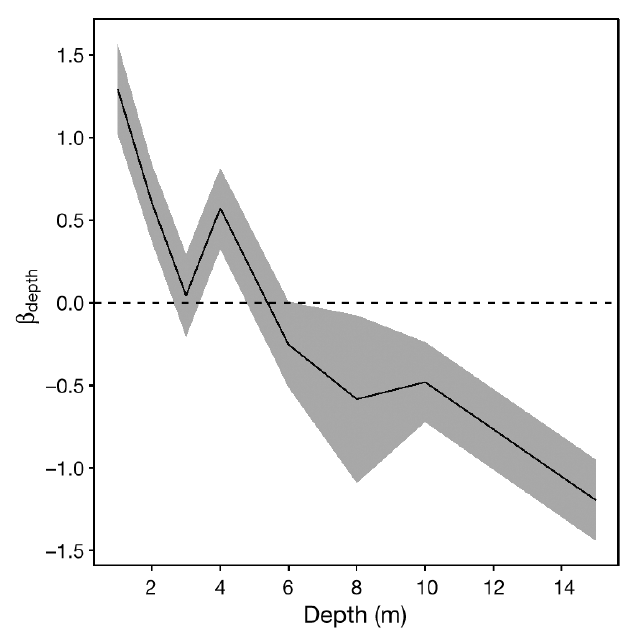
Fig. 4. Posterior mean of the smoothed depth regression ef- fect ( β depth ) on expected Mytilus spat with 95% confidence intervals (grey shading)